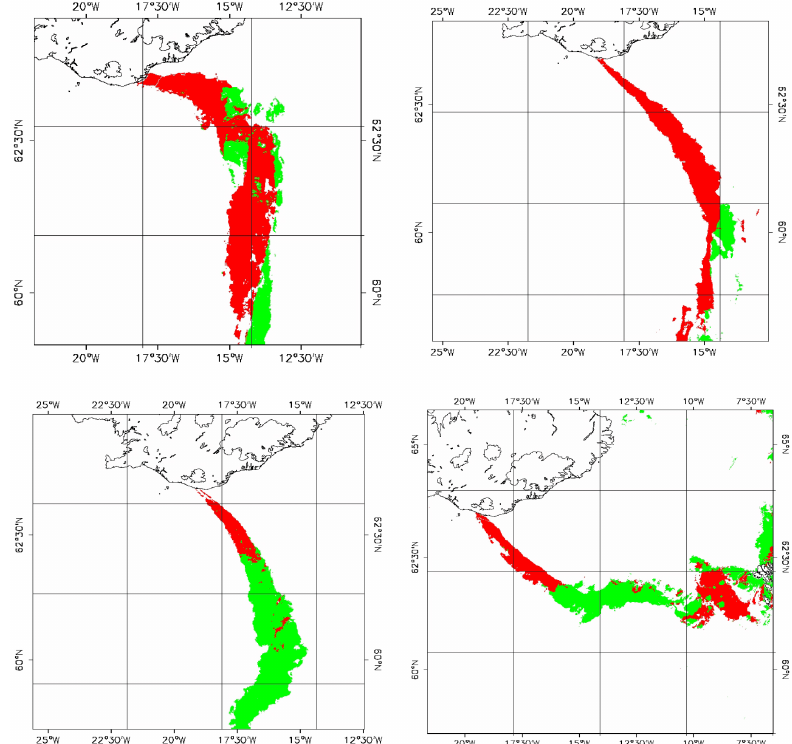
Figure 3. Ash detection maps of training data sets: 6 May 2010, 11:55UTC (top left); 7 May 2010, 14:30UTC (top right); 8 May 2010, 13:20UTC (bottom left); 13 May 2010, 12:00UTC (bottom right). Volcanic ash clouds over sea alone in red, ash clouds over meteorological clouds in green.